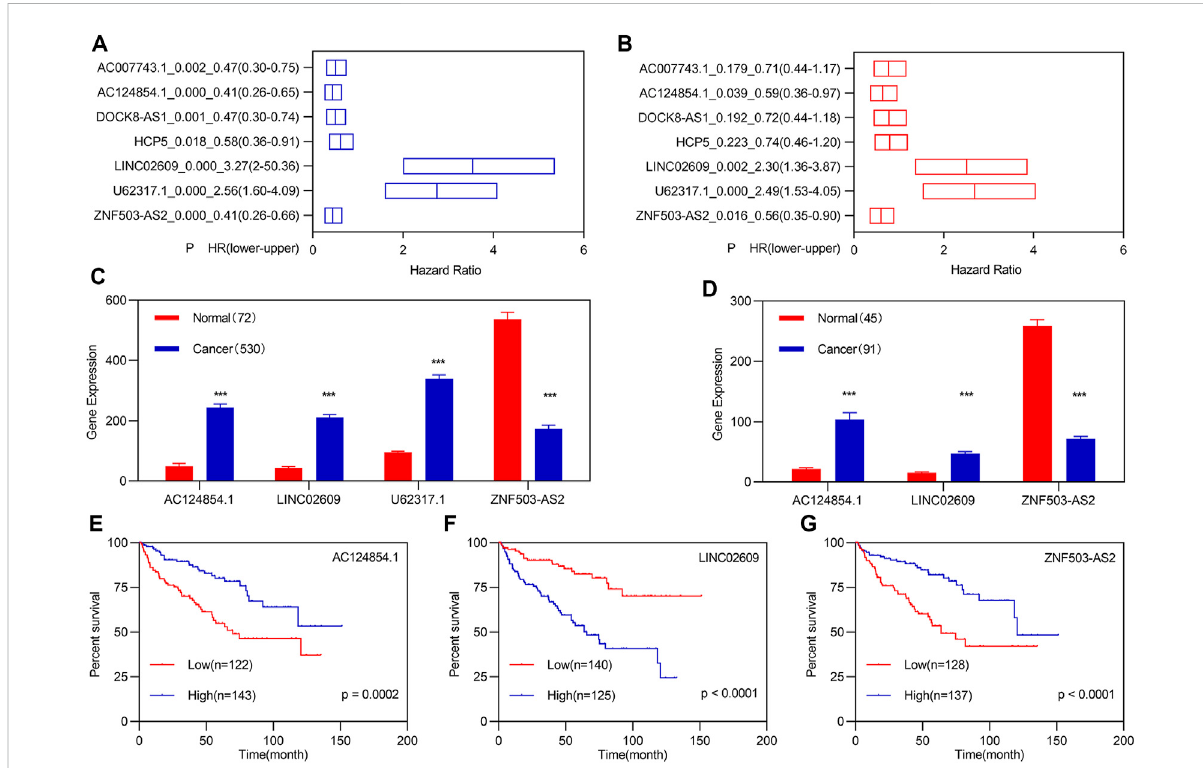
FIGURE 1 Identi fi cation of FI-DEGsas candidate biomarkers. (A) K-M analysis illustratedthat seven FI-DELs were correlated with OS of patients with KIRC followed by LASSO analysis and WGCNA. (B) Multivariate Cox regression analysis illustrated that the four FI-DELs were correlated with the OS of patients with KIRC independently. (C) Expression of the four FI-DELs between normal and patients with KIRC in TCGA dataset. (D) Expression of the threeFI-DELsbetweennormalandpatientswithKIRCintheICGCdataset. (E – G) K-McurveofthethreeFI-DELsinthetraininggroup.* p < 0.05, ** p < 0.01, *** p <